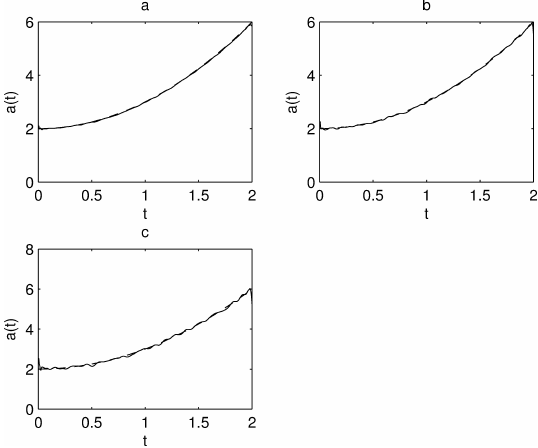
Fig. 4. The exact and approximate solutions of a(t), after thresholding, (a) for 3 % noisy data, (b) for 5 % noisy data, (c) for 10 % noisy data. In figure (a)-(c) the exact solution is shown with dashed line.